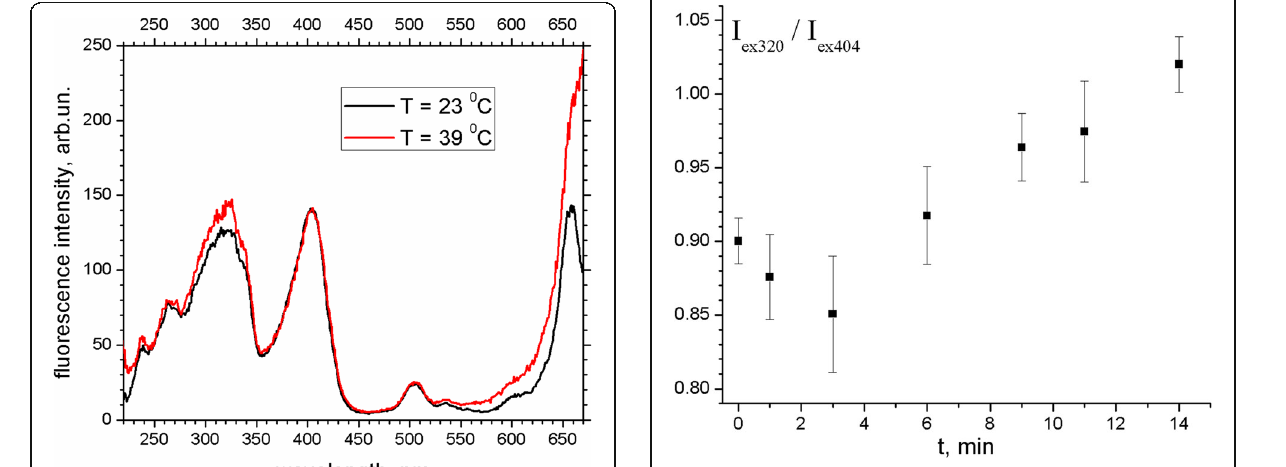
Fig. 9 The dependence on the time after the heating to 39 °C was switched on of the ratio of the emission intensity of chlorin e 6 added to PS-PPO-PNIPAM hybrid NS at 680 nm upon excitation at 320 nm (absorption by PPO with further EEET to chlorin e 6 ) to that upon excitation at 404 nm (direct excitation of chlorin e 6 ). Error bars account for the noise of the registered excitation